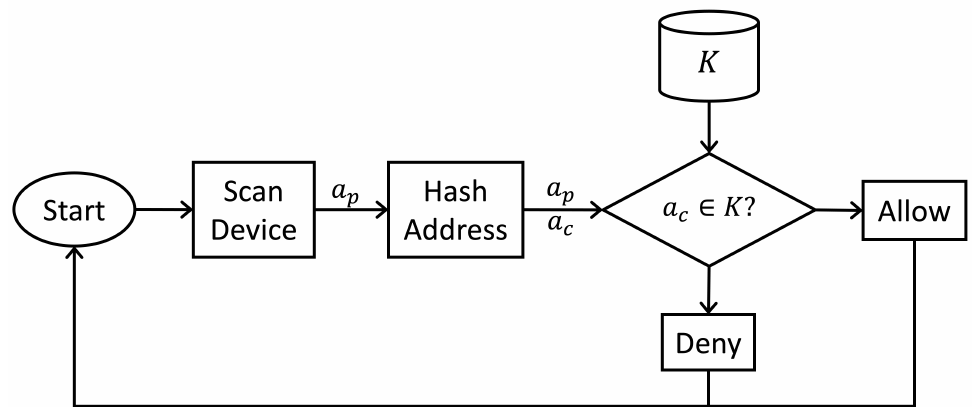
Figure 12. A flowchart illustrating how the proposed embedded countermeasure against MQTT- based MitM and masquerade attacks